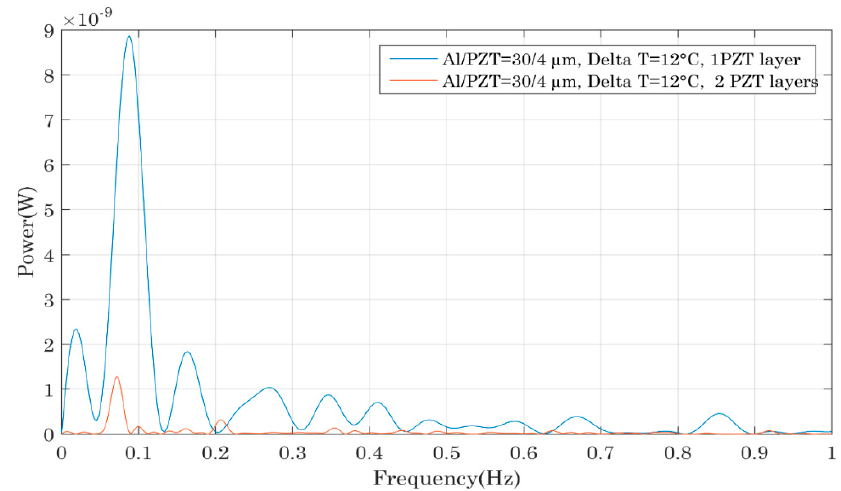
Figure 11. Impact on the device’s output power of the number of PZT thin films deposited onto the bimetal.